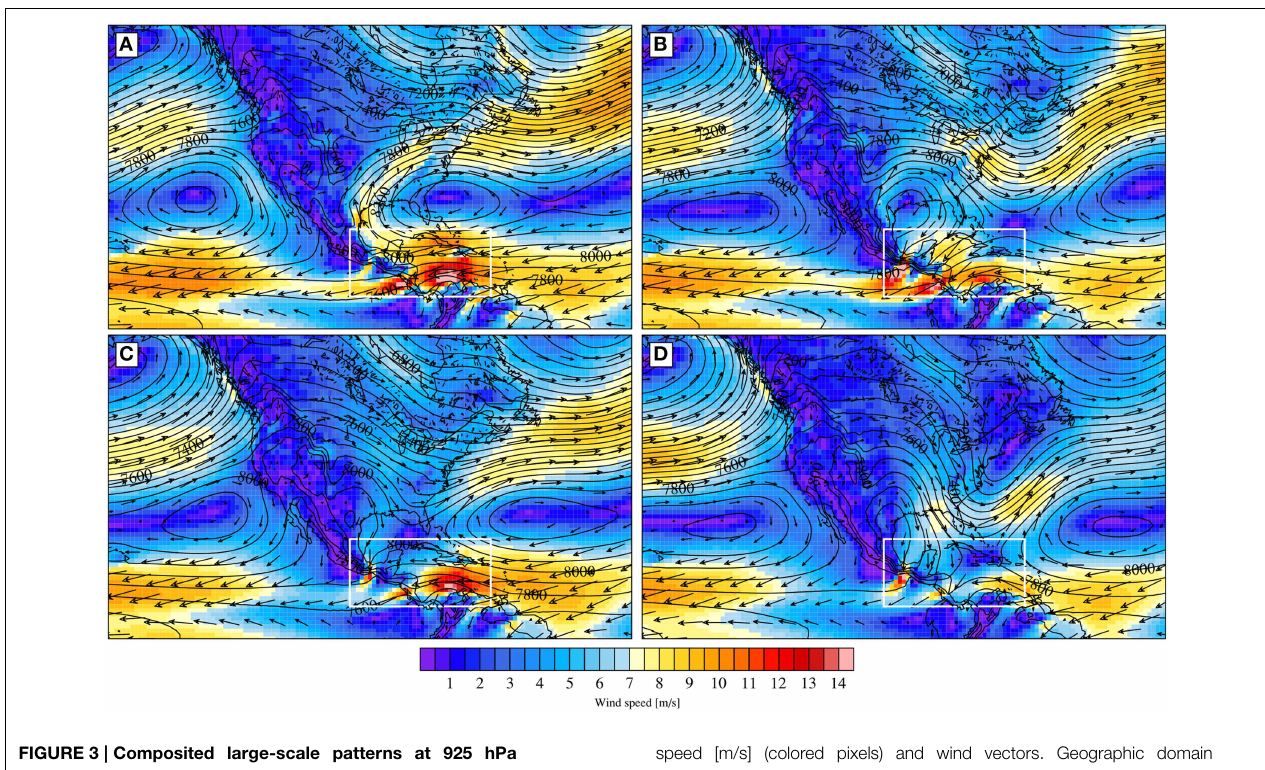
FIGURE 3 | Composited large-scale patterns at 925 hPa associated with (A) WNEW, (B) WNCS, (C) WGCS, and (D) WNWS regimes. Geopotential height [ m 2 / s 2 ] (black contours), wind